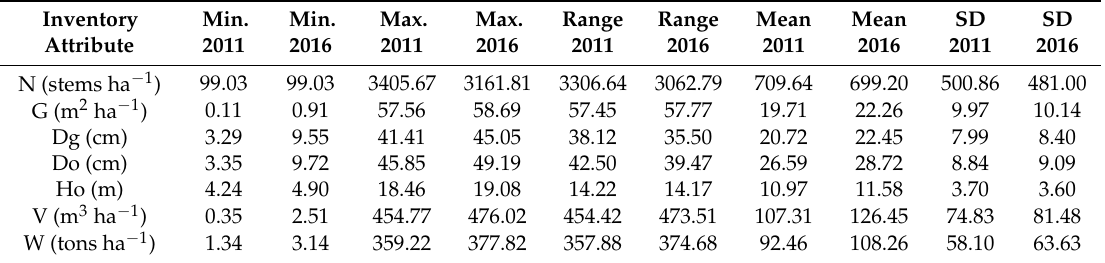
Table 4. Summary of the estimated field plot attributes using single-tree growth models for each